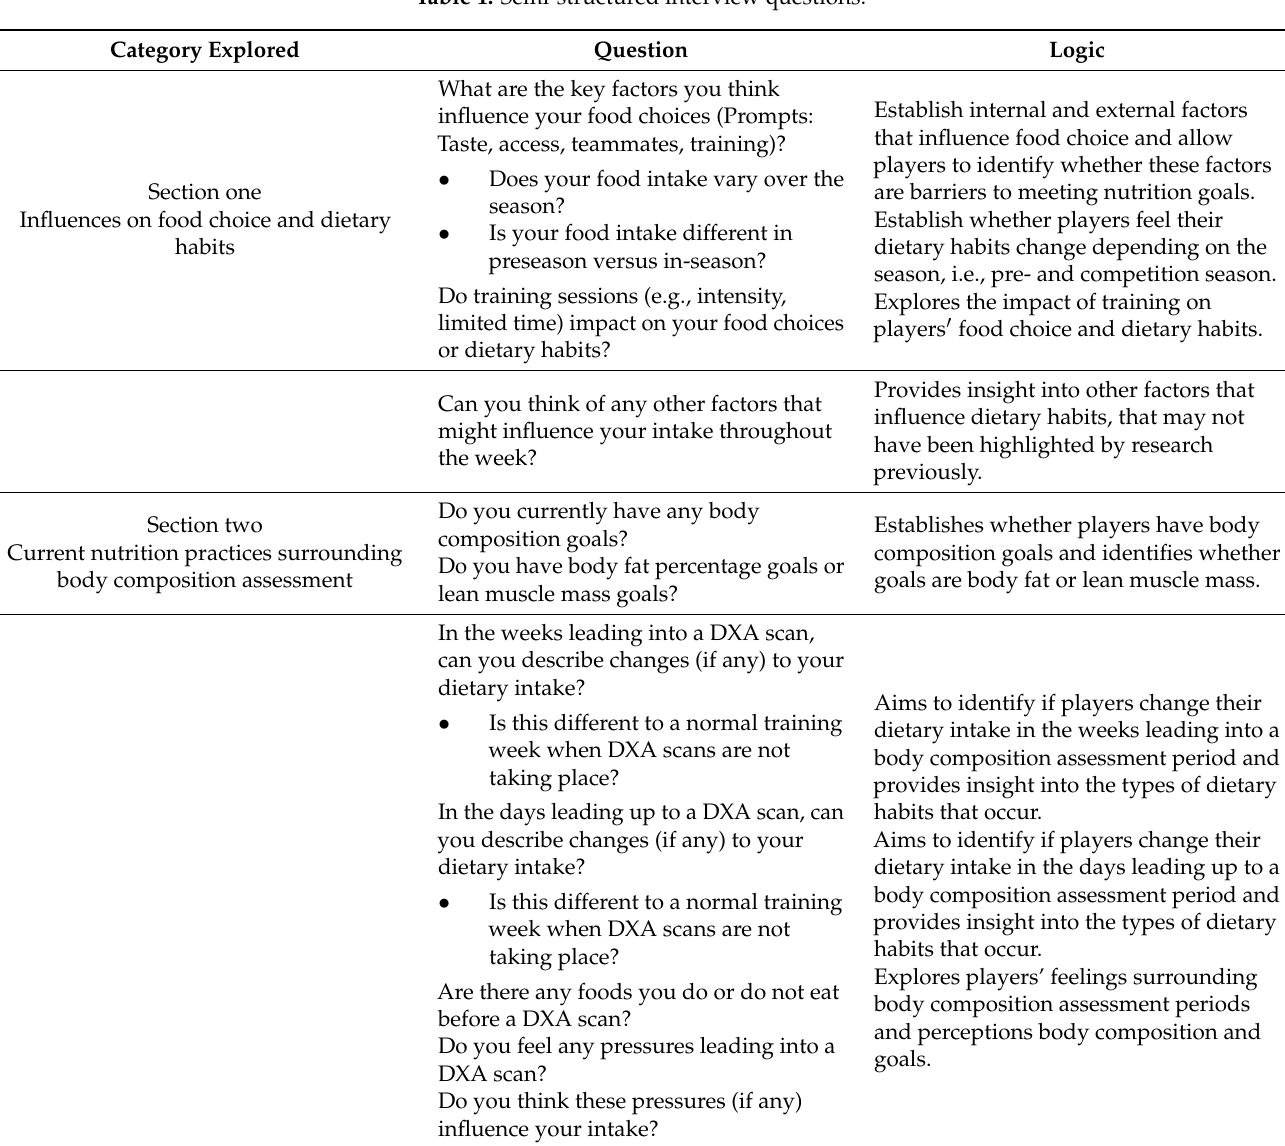
Table 1. Semi-structured interview